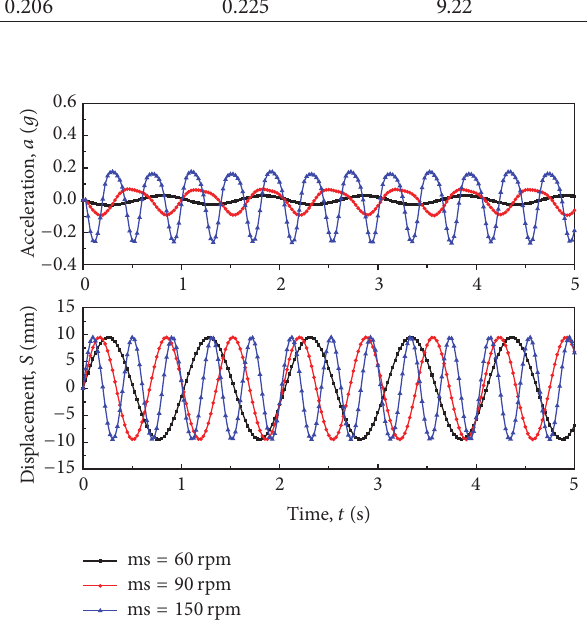
Figure 3: Vibration acceleration and displacement profiles under different motor speeds.